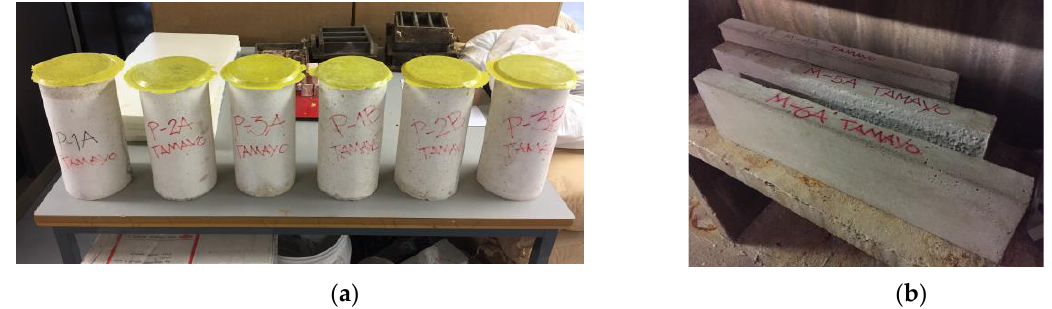
Figure 5. Final preparation of specimens. ( a ) Cylindrical specimens; ( b ) Rectangular specimens.